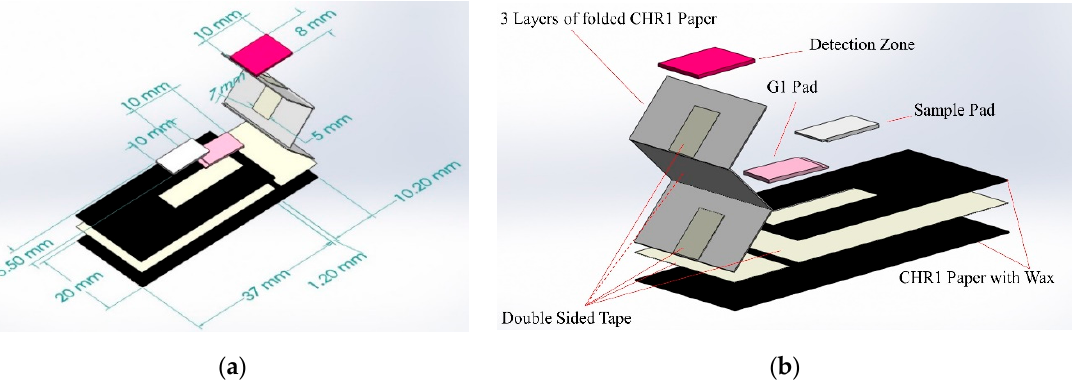
Figure 3. ( a ) Dimensions of the device and its components; ( b ) components of the paper-based microfluidic device.